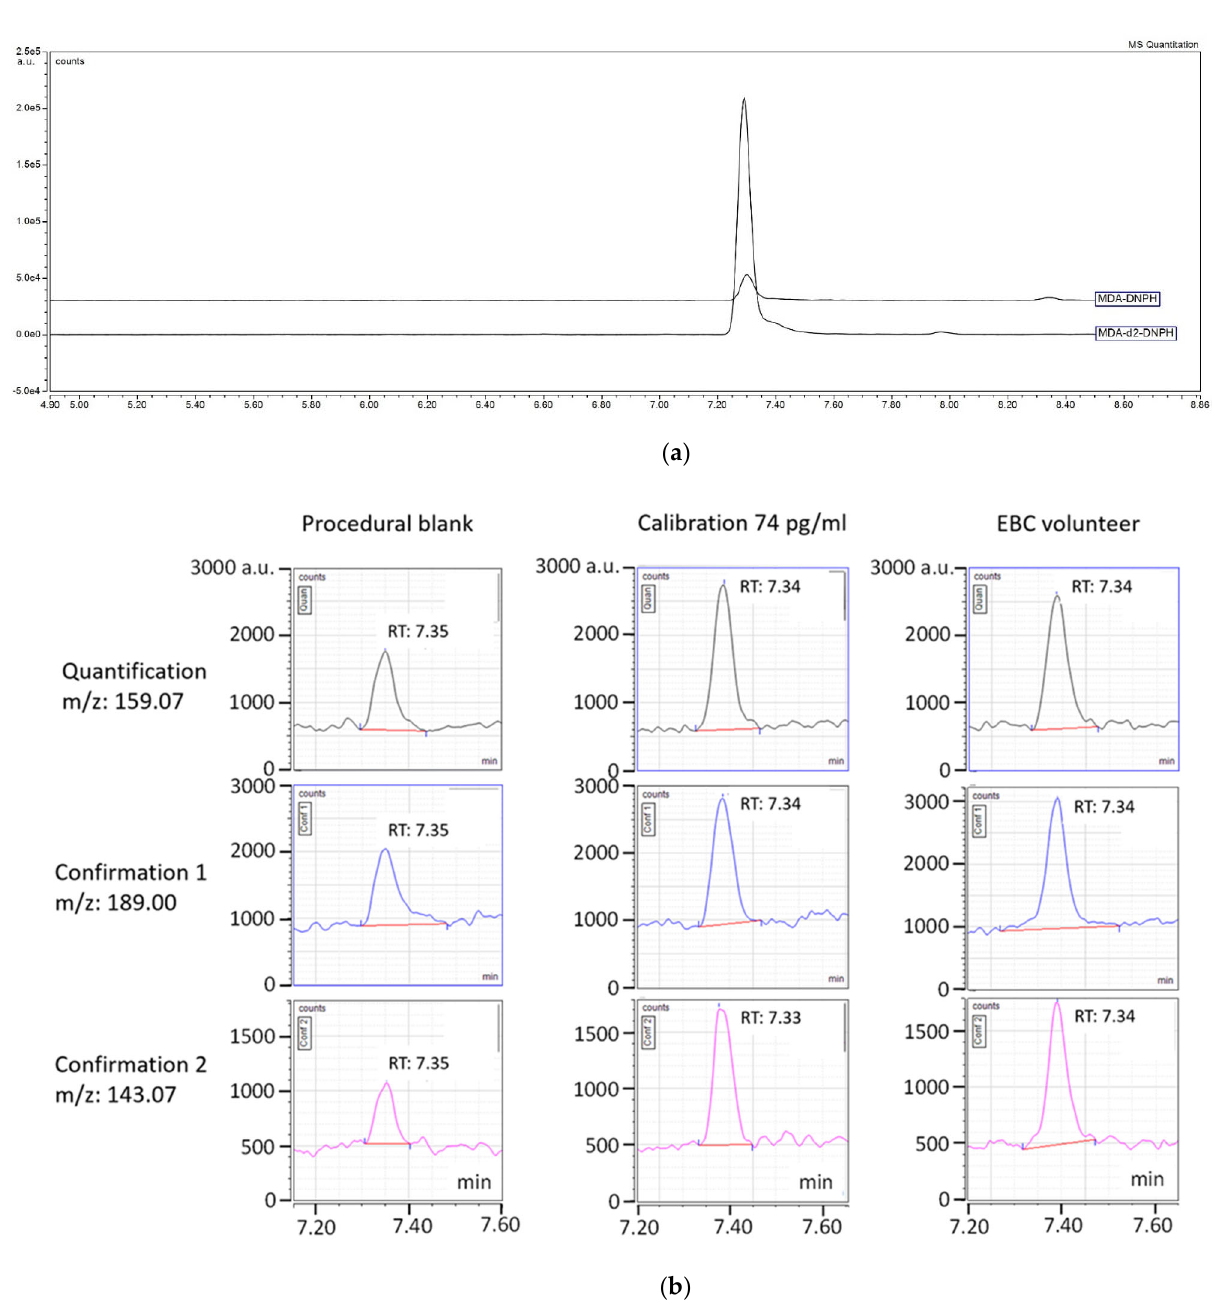
Figure 1. ( a ) Chromatogram of procedural blank and its internal standard and multi-reaction monitoring (MRM) transitions for MDA ( b ) Partial chromatogram of a procedural blank, of the lowest standard MDA concentration, and of a typical EBC sample, with retention times (RT). The units of the y ‐ axis are in arbitrary units, counts per second.